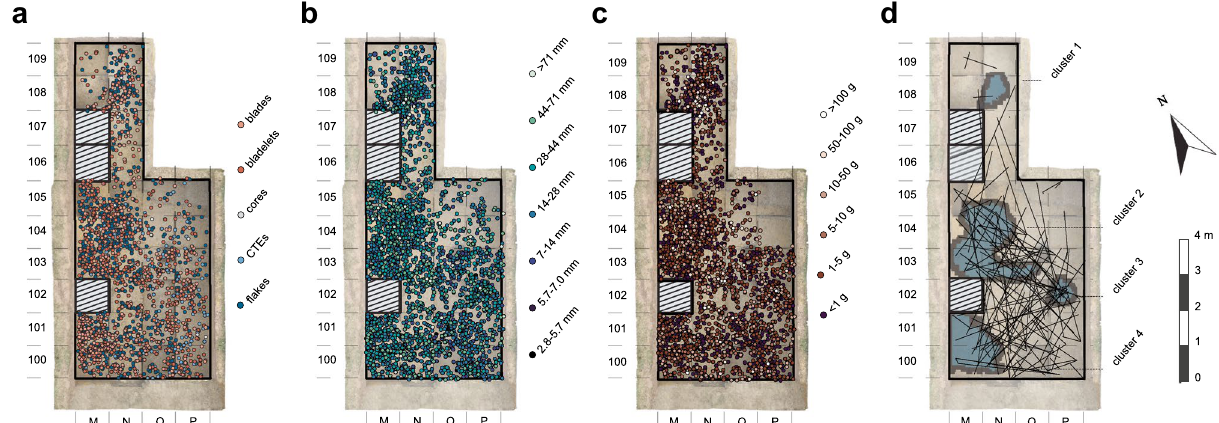
Figure 3. Top-down orthophoto (final excavation depths) of the 2016–19 excavations at Române ș ti- Dumbrăvi ț a I with lithic artifacts projected from GH3 (Aurignacian). ( a ) Lithic type distribution; ( b ) lithic size